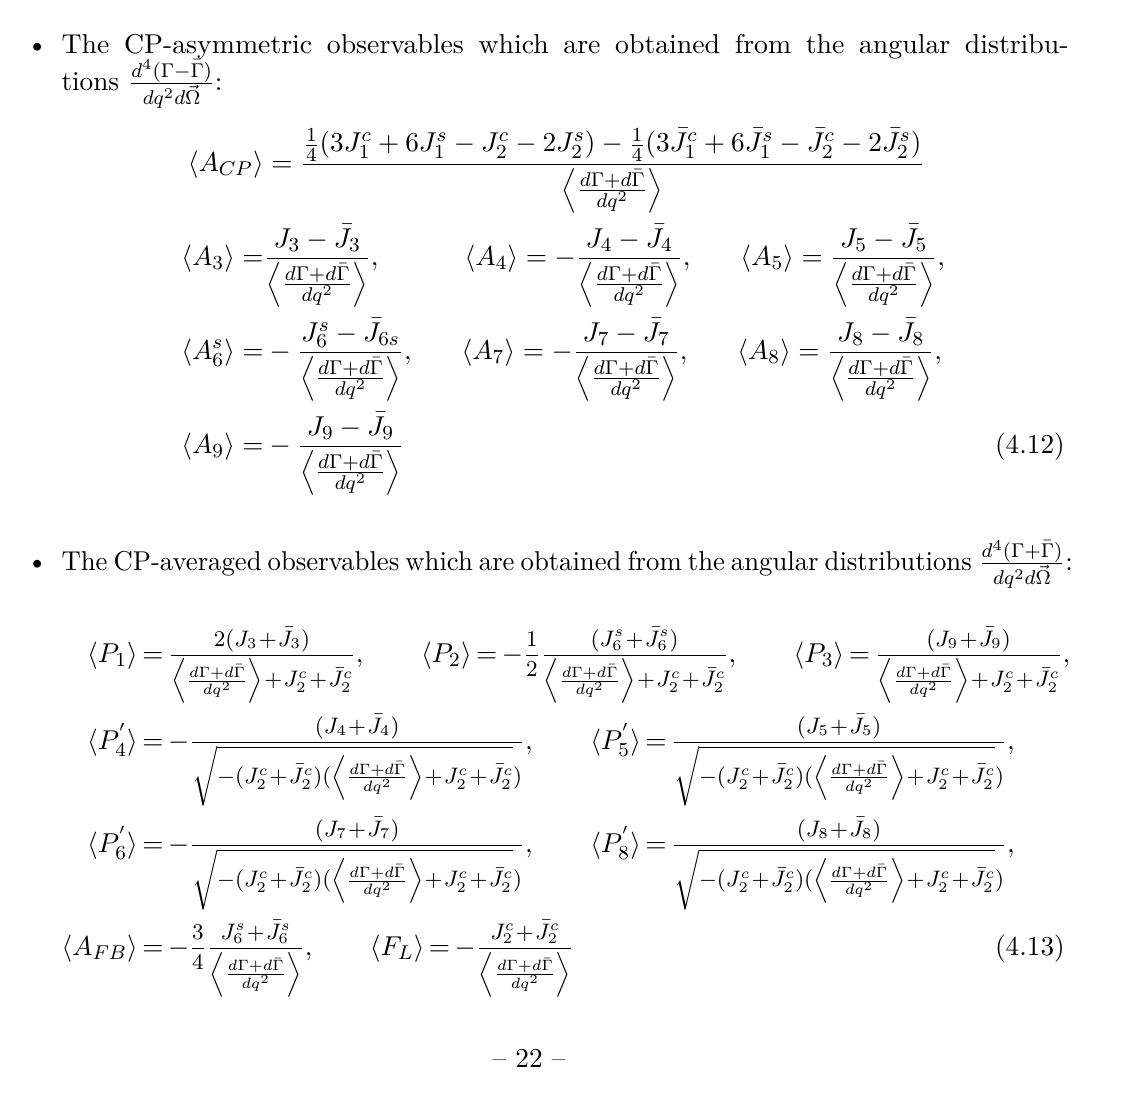
Table 11 . The observables along with the respective new physics scenarios which affect them the most. In the NP scenarios, the q 2 sensitivity of these observables can be visualized from the corresponding plots provided in the text. Numerical estimates for the same calculated at a few benchmark values for the NP WC’s can also be read off from the relevant